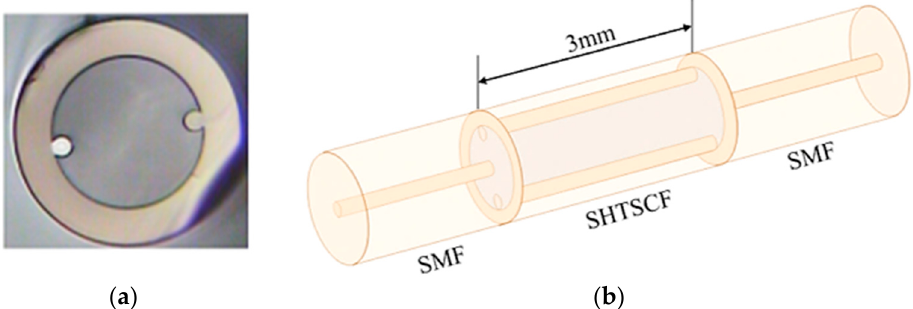
Figure 1. Schematic diagram of the SHTSCF ( a ) Cross-sectional microscopic magnified image of SHTSCF; ( b ) Schematic of sensor structure.